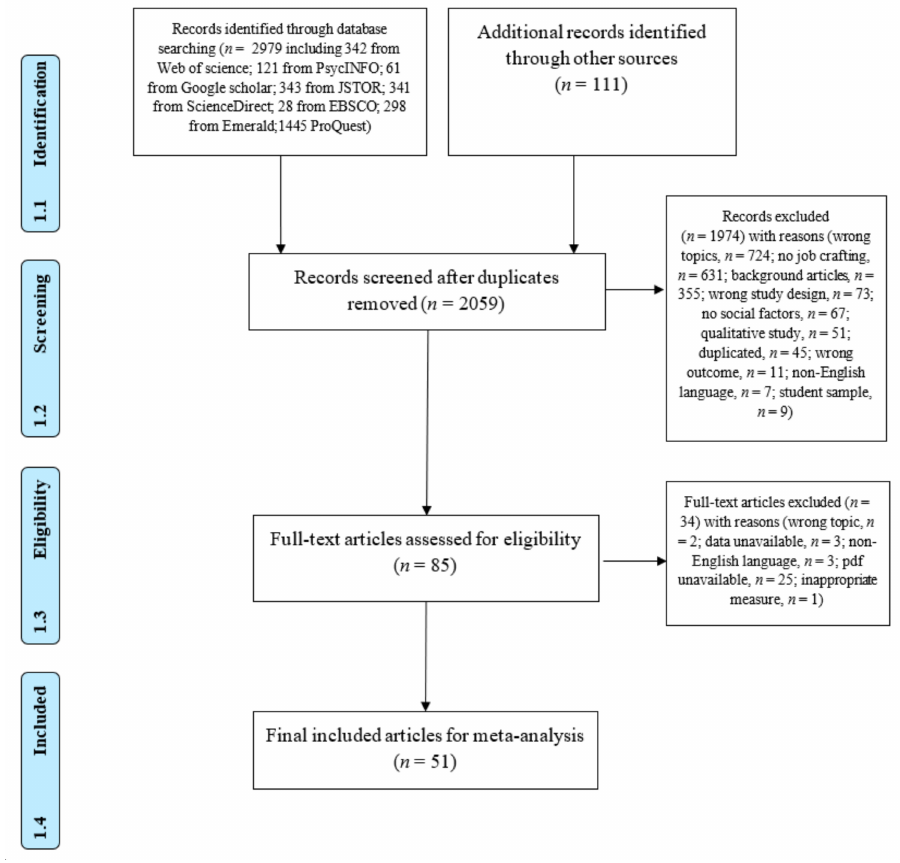
Figure A1. The flow diagram of literature searching process. Note: Figure is adapted from Moher, Liberati, Tetzla ff , Altman, The PRISMA Group,